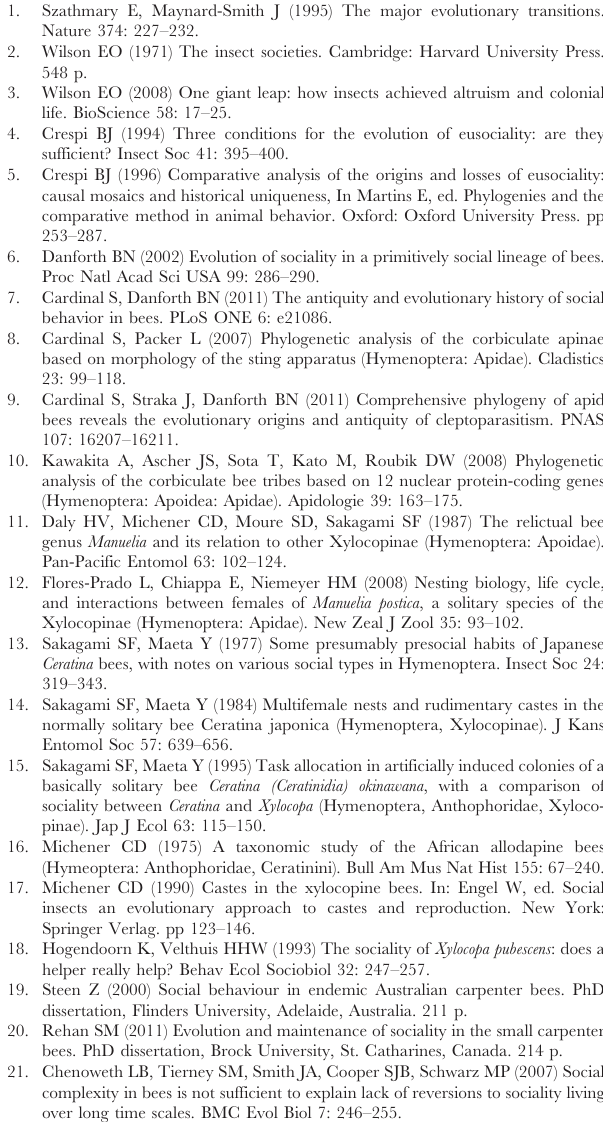
and references for this status for Xylocopinae species in our